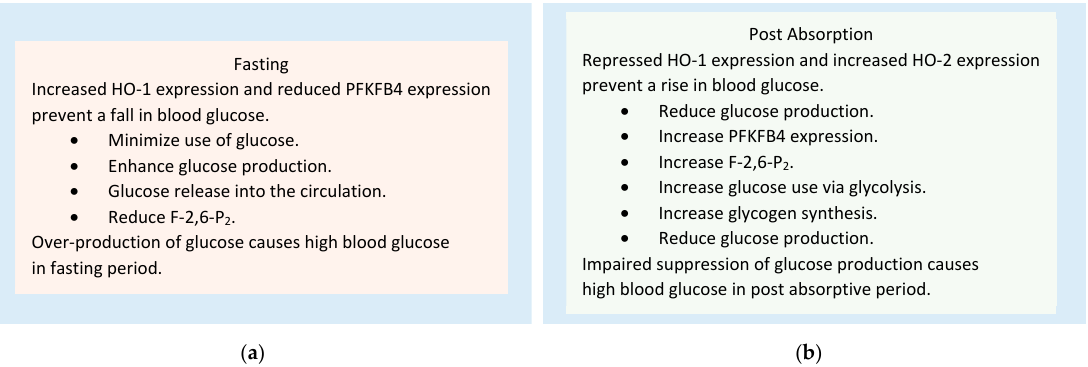
Figure 3. Co-ordinated expression of HO-1, HO-2, and PFKFB4. ( a ) Changes in expression of HO-1 and PFKFB4 in the fasting state.; ( b ) Changes in expression of HO-1, HO-2, and PFKFB4 in the post absorptive period. Abbreviations: PFKFB4, 6-phosphofructo-2-kinase/fructose-2,6-biphosphatase 4; F-2,6-P 2 , fructose 2,6-biphosphate.